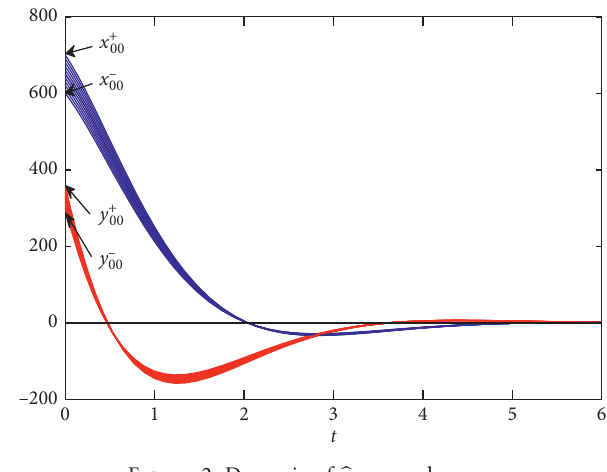
Figure 2: Dynamic of 􏽢 φ